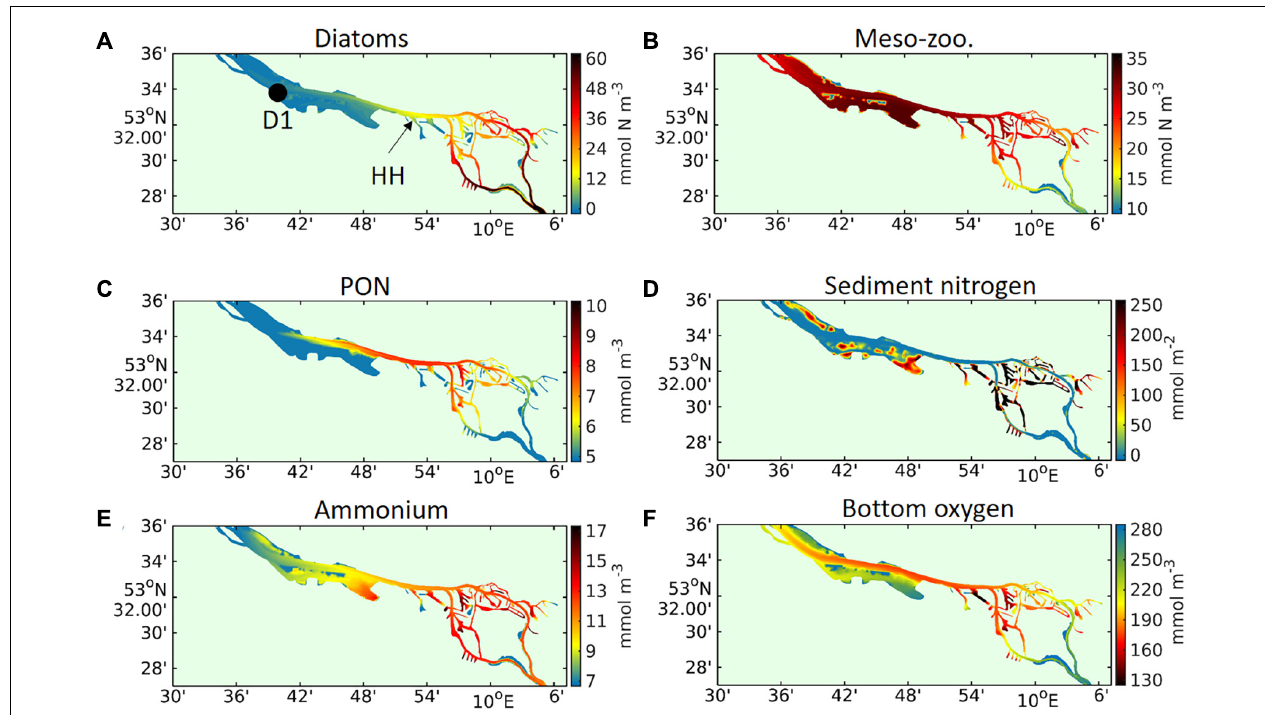
FIGURE 10 | Model-simulated vertically averaged and time-averaged concentrations of (A) diatom biomass nitrogen, (B) meso-zooplankton biomass nitrogen, (C) particulate organic matter, and (E) ammonium in the area of the port of Hamburg. In (D,F) the model-simulated time-averaged (D) mass per square meter of sediment nitrogen and (F) near-bottom dissolved oxygen concentration are given for the same area and period of May to September 2012. In (A) the locations of two measuring stations are marked by a black dot (station “D1,” see Figure 1 ) and by a black arrow (stations Seemannshöft, see label “HH” in Figure 1 ).